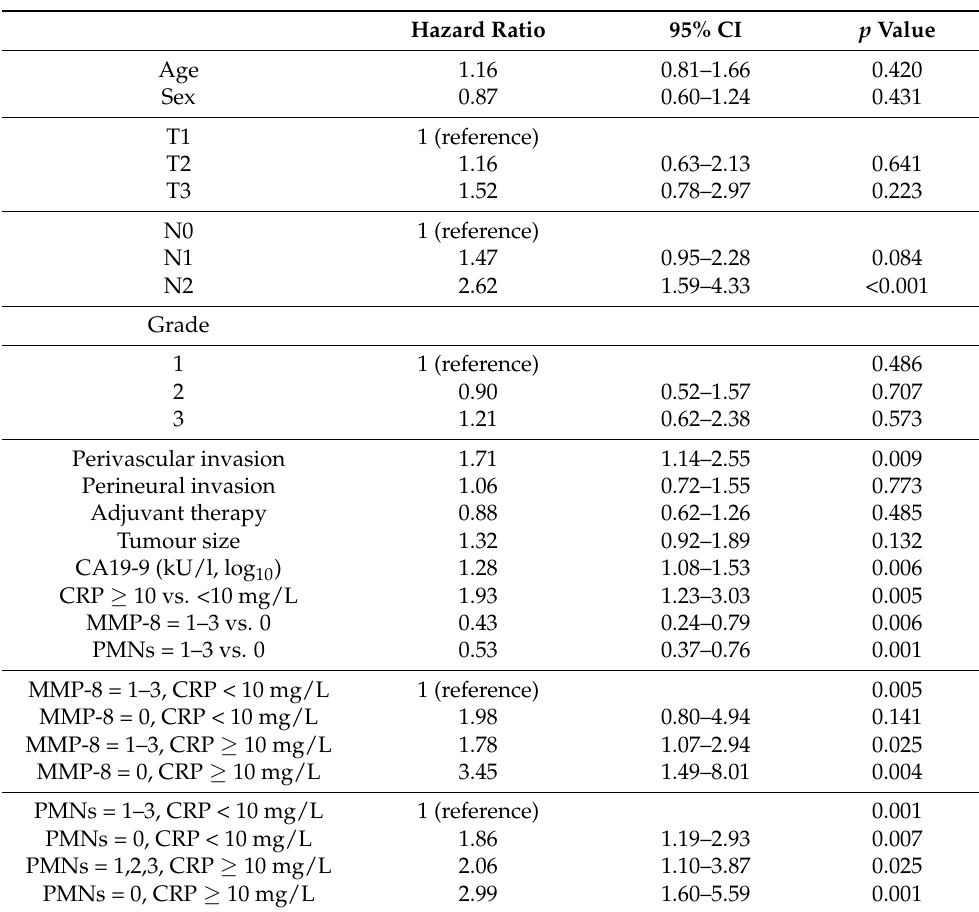
Table 2. Univariable analysis of relative risk of death from pancreatic ductal adenocarcinoma (PDAC) by matrix metalloproteinase 8 (MMP-8) expression level in cancer cells, the amount of tumour- associated MMP-8 positive polymorphonuclear cells (PMNs), the plasma C-reactive protein (CRP) level and clinicopathological